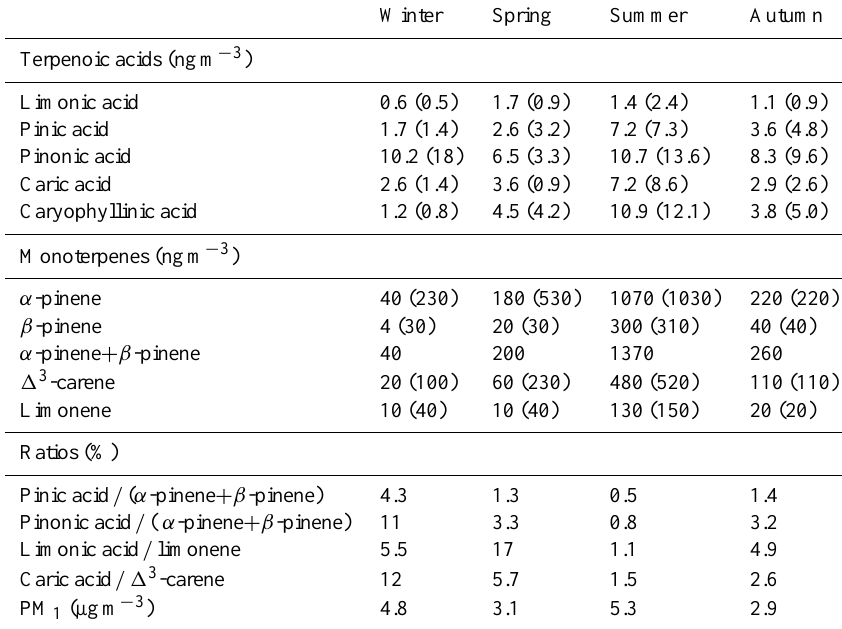
Table 1. Seasonal mean concentrations (standard deviations) of terpenoic acids from this study and precursor monoterpenes from Hakola et al. (2012) in Hyytiälä (June 2010–October 2011). Also included are the ratios between acids and precursors (%) and mean PM 1 concentra-